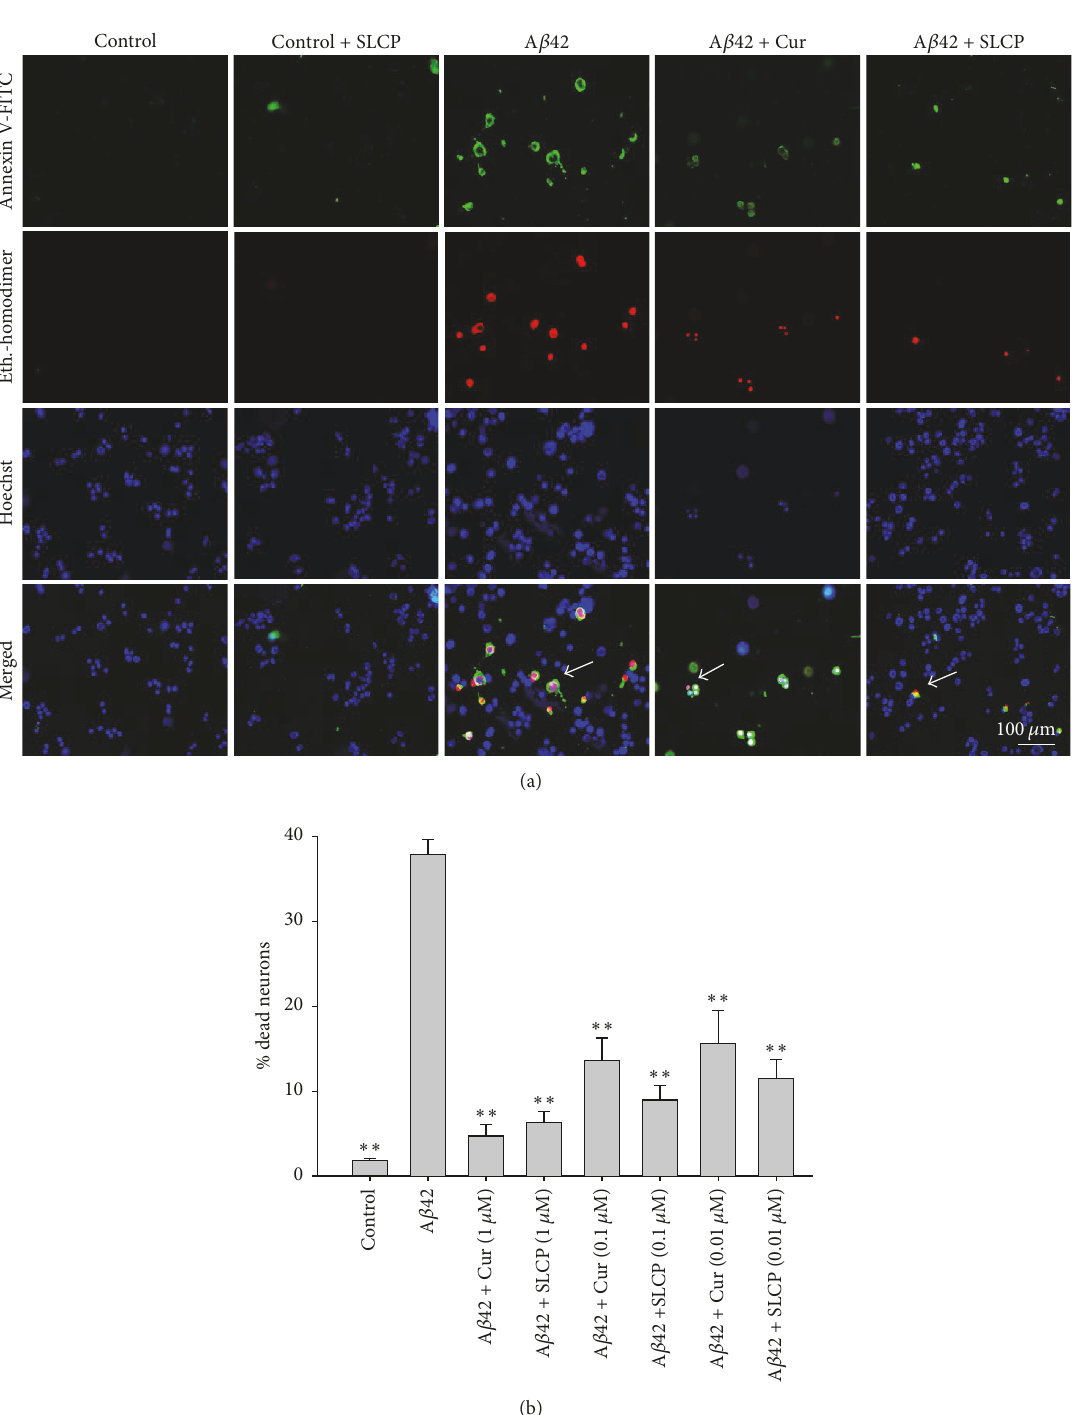
Figure 4: SLCP prevented A 𝛽 42-induced neuronal apoptosis. N2a cells were treated with A 𝛽 42 (10 𝜇 M) for 24 h in presence and absence of dietary Cur and SLCP (1 𝜇 M) and apoptotic cell death was monitored with Annexin-V staining. (a) Images showed that apoptotic death was increased after exposure to A 𝛽 42, whereas SLCP treatment prevented the neuronal death. (b) Morphometric analysis indicates that A 𝛽 42 induces almost 40% neuronal apoptosis and treatment of different concentrations of Cur and/or SLCP decreased cell death significantly ( ∗∗ 𝑝 < 0.01 compared with A 𝛽 42 alone). Green fluorescent indicates apoptotic death; red is nuclear stain. Arrows indicate apoptotic cells. Scale bar indicates 100 𝜇 m and is applicable to all other